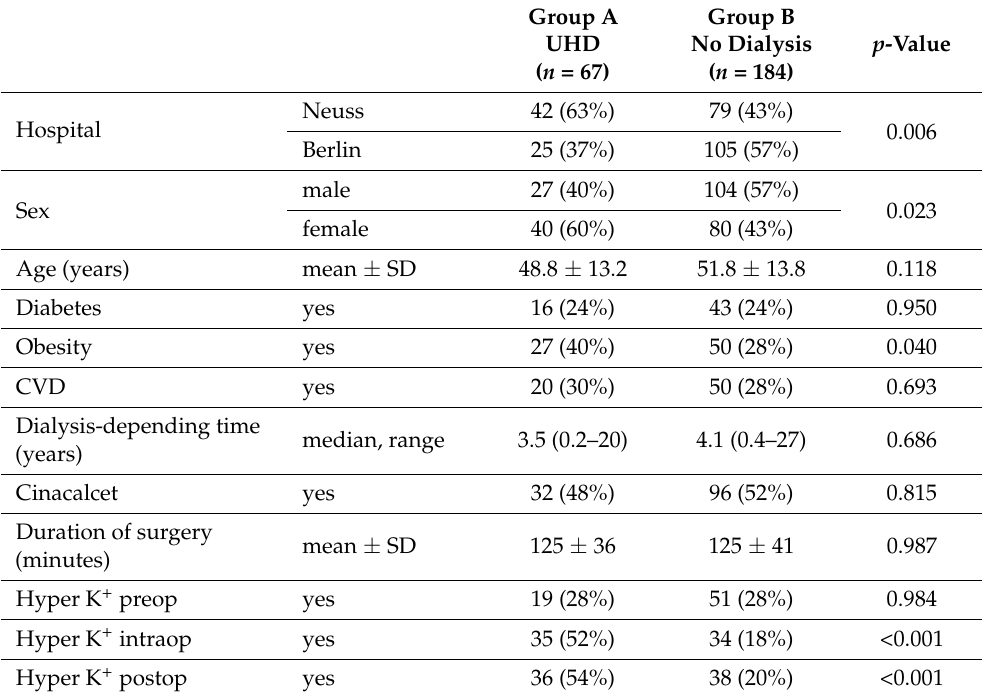
Table 3. Comparison of demographic parameters and occurrence of perioperative hyperkalemia between urgent hemodialysis (UHD) recipients (group A) and control B (no